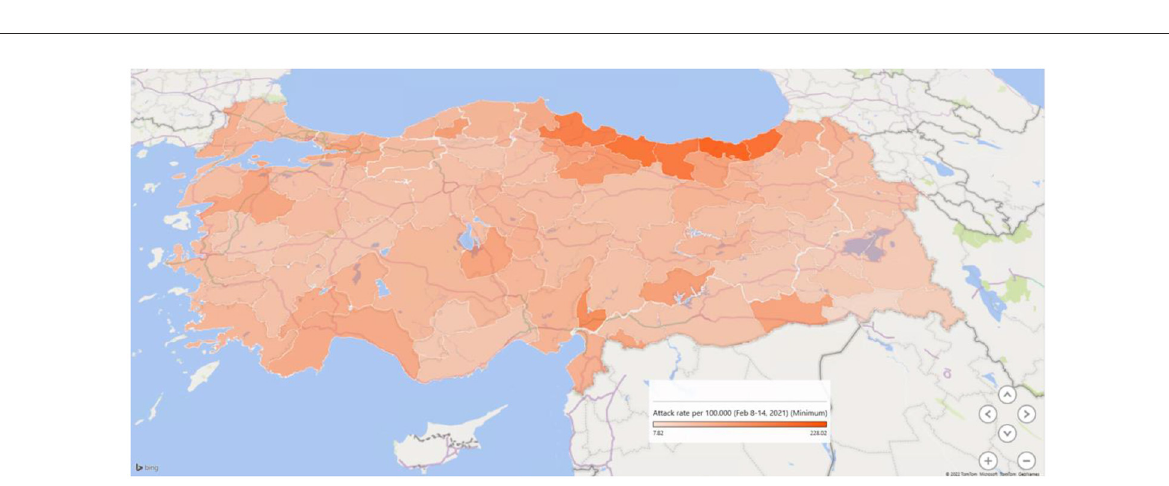
income, and wealth gaps are associated with more COVID-19 cases, hospitalizations, and deaths